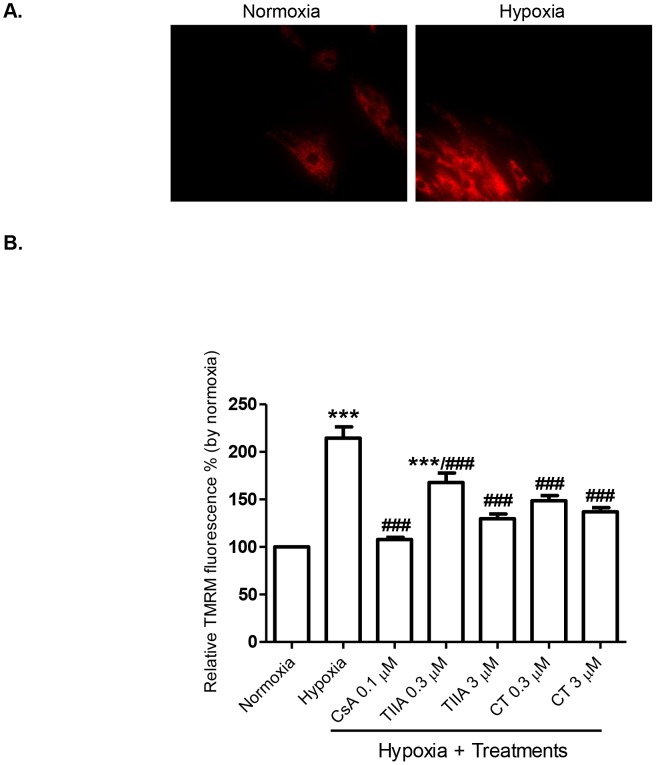
Effects of TIIA, CT, and CsA on hypoxia induced hyperpolarization in mitochondrial membrane. (A) Images of cells stained with TMRM in normoxia control cells and cells after 8 hr hypoxia. (B) Quantitative data of TMRM fluorescence intensity measured by microplate reader. Values shown are mean ± SEM from n = 3, *** P<0.001 vs. normoxia, ### P<0.001 vs. hypoxia.